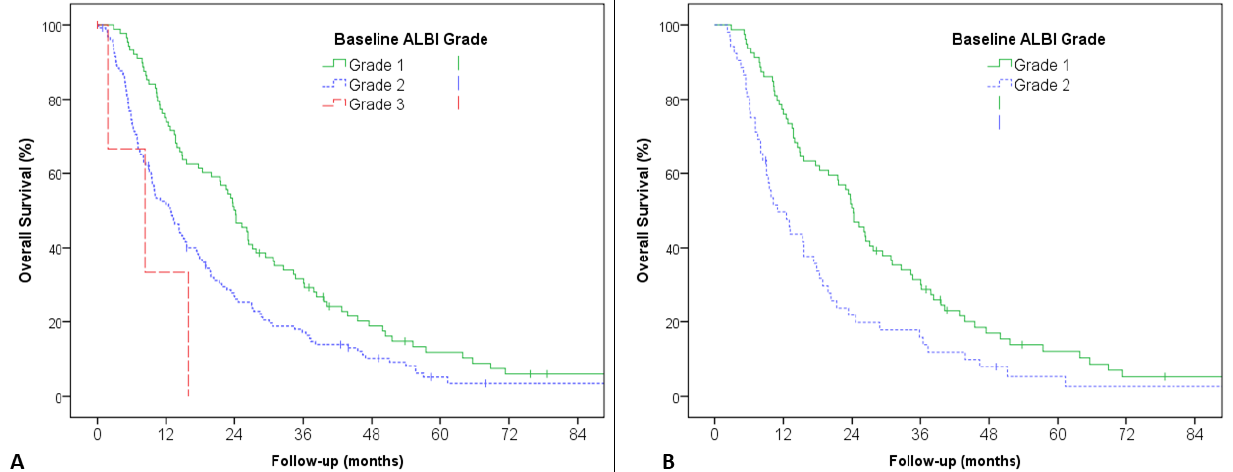
Figure 1. Overall survival according to baseline ALBI grade, ( A ) in the overall population, and ( B ) in patients with Child − Pugh A5.